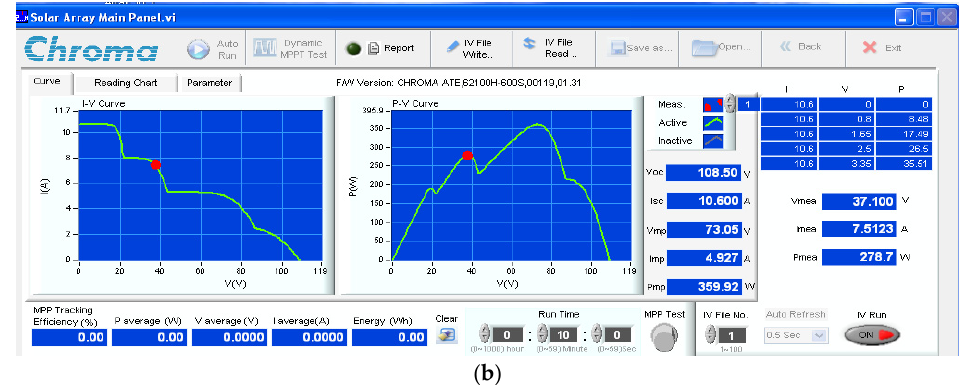
Figure 20. P ‐ V and I ‐ V curves under PSC; ( a ) the detected GMPP by S1 and S3 and ( b ) the failed detection of GMPP by S2.